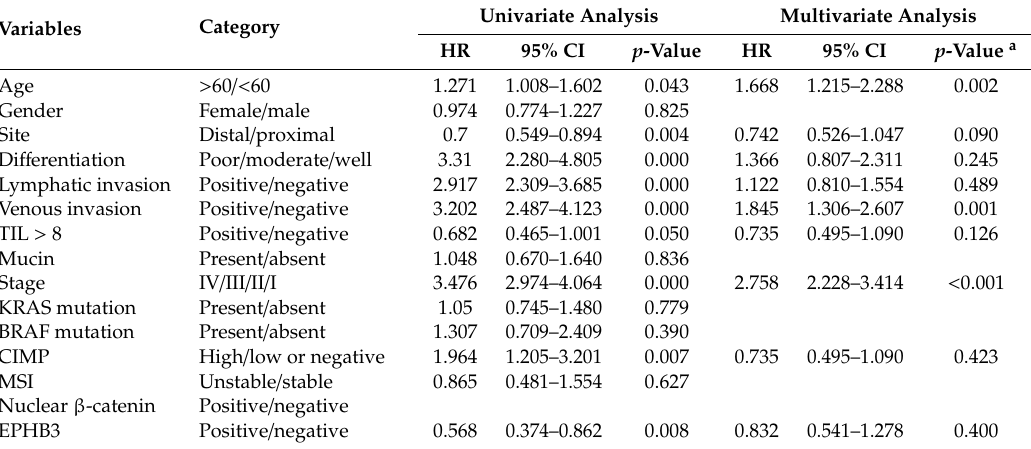
Table 3. The results of univariate and multivariate analysis for survival rate in colorectal cancers.